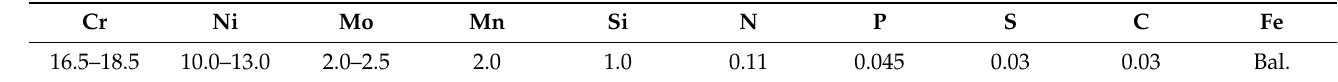
Table 2. Chemical composition of SUS 316L powder (wt.%).